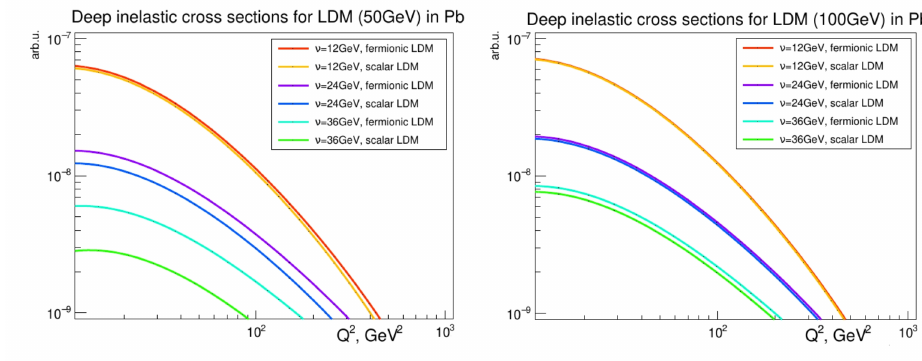
Figure 8. DIS cross sections for LDM with energies 50 GeV (left) and 100 GeV (right) in lead.